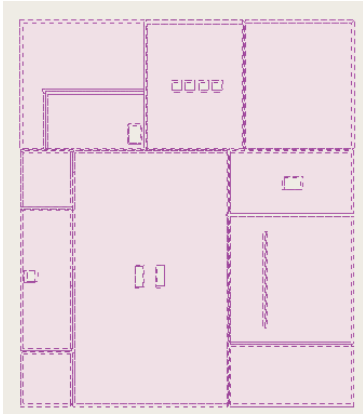
Figure 5: Movement spaces of the museum.